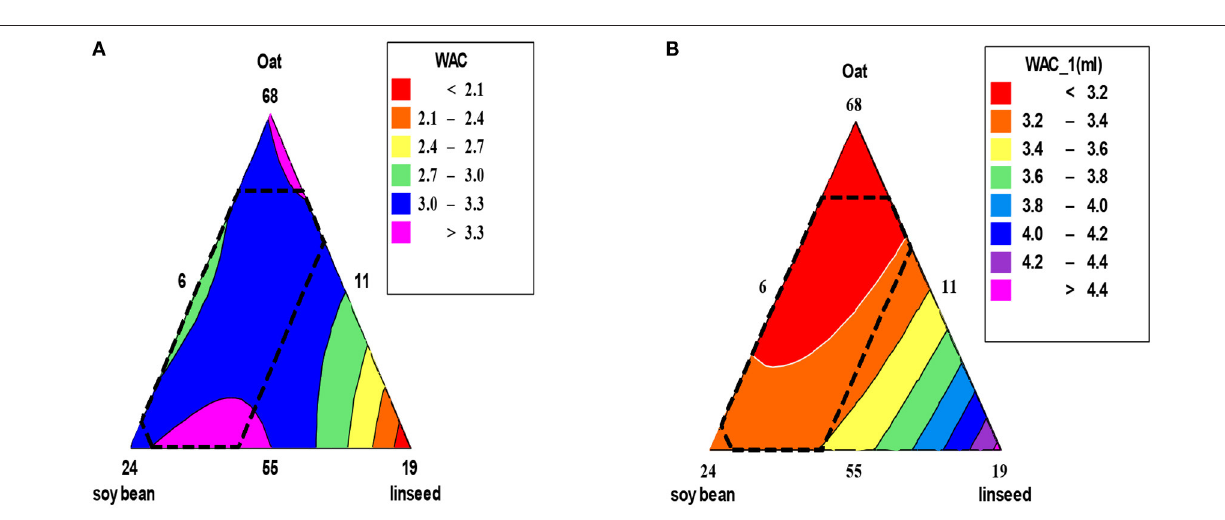
FIGURE 5 | Contour plot of WAC (ml) of the extruded (A) and unextruded (B) composite